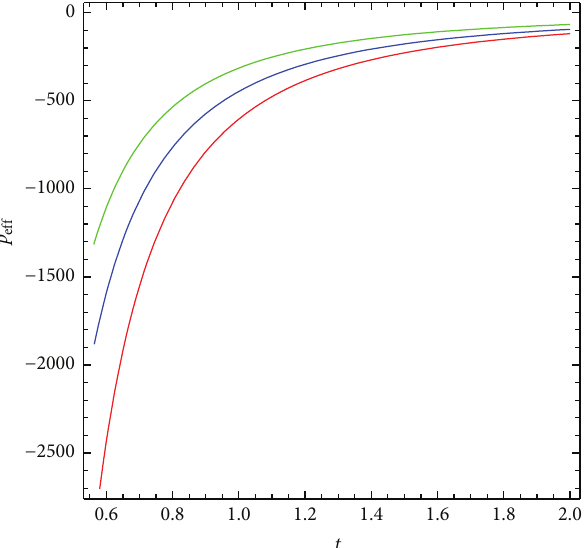
Figure 2: Plot of 𝑝 eff = 𝑝+Π . Red, green, and blue lines correspond to {𝛼,𝛽} combination of {0.9735, 3701} and {0.9735, 3701} with 𝜂 = 3.5 × 10 −4 , 3.0 × 10 −4 , and 2.5 × 10 −4 , respectively.